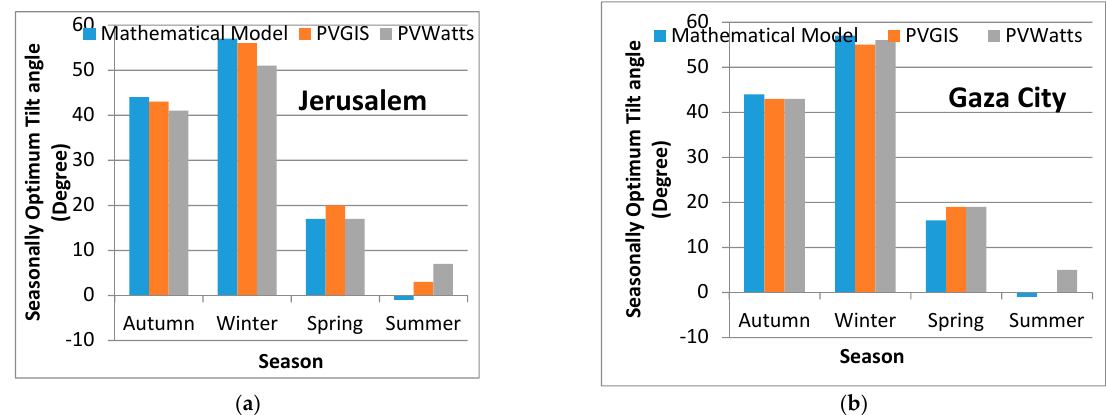
Figure 10. A comparison of seasonal optimum tilt angles based on PVWatts and PVGIS with those calculated by the mathematical model: Jerusalem ( a ), Gaza city ( b ).